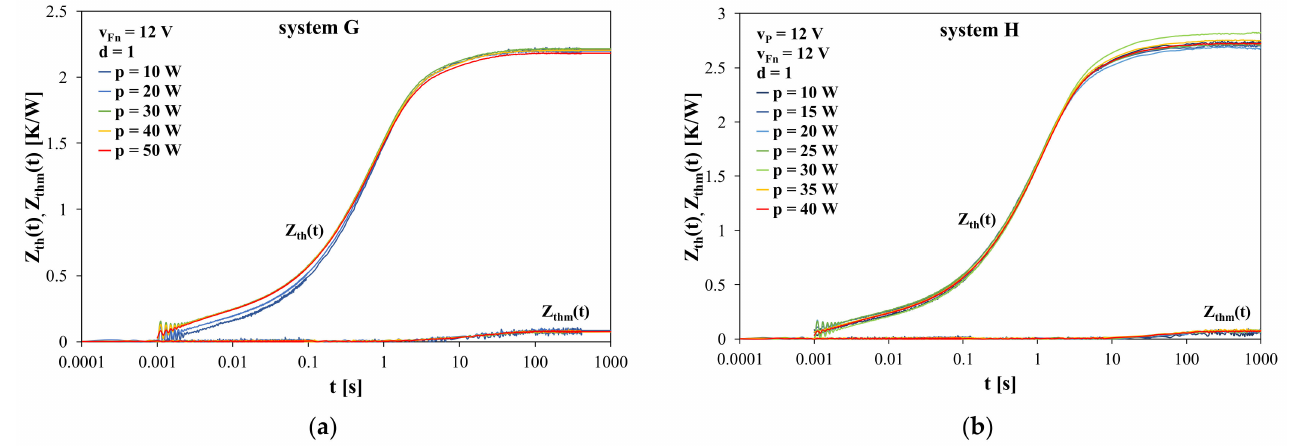
Figure 9. Transient thermal impedances Z th (t) and Z thm (t) of the investigated MOSFETs with the cooling system ( a ) G and ( b ) H.